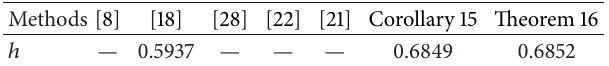
Table 2: Maximum upper bound of ℎ with different